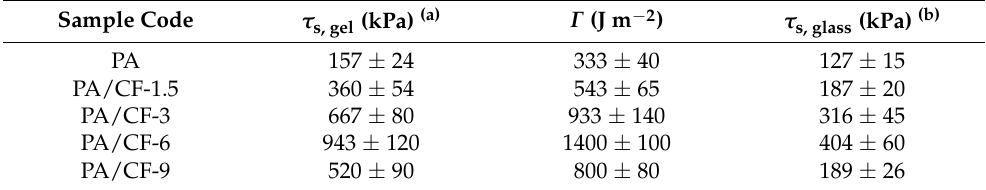
Figure 6. 90-degree peeling adhesion behavior of two pieces of PA/CF composite hydrogels with different ϕ CF . ( a ) Peeling force ( F )-extension ( Δ ) curves of the samples. ( b ) Adhesive energy versus ϕ CF . Table 2. A summary of the adhesion properties of PA/CF composite hydrogels with different CF contents (shown in Figures